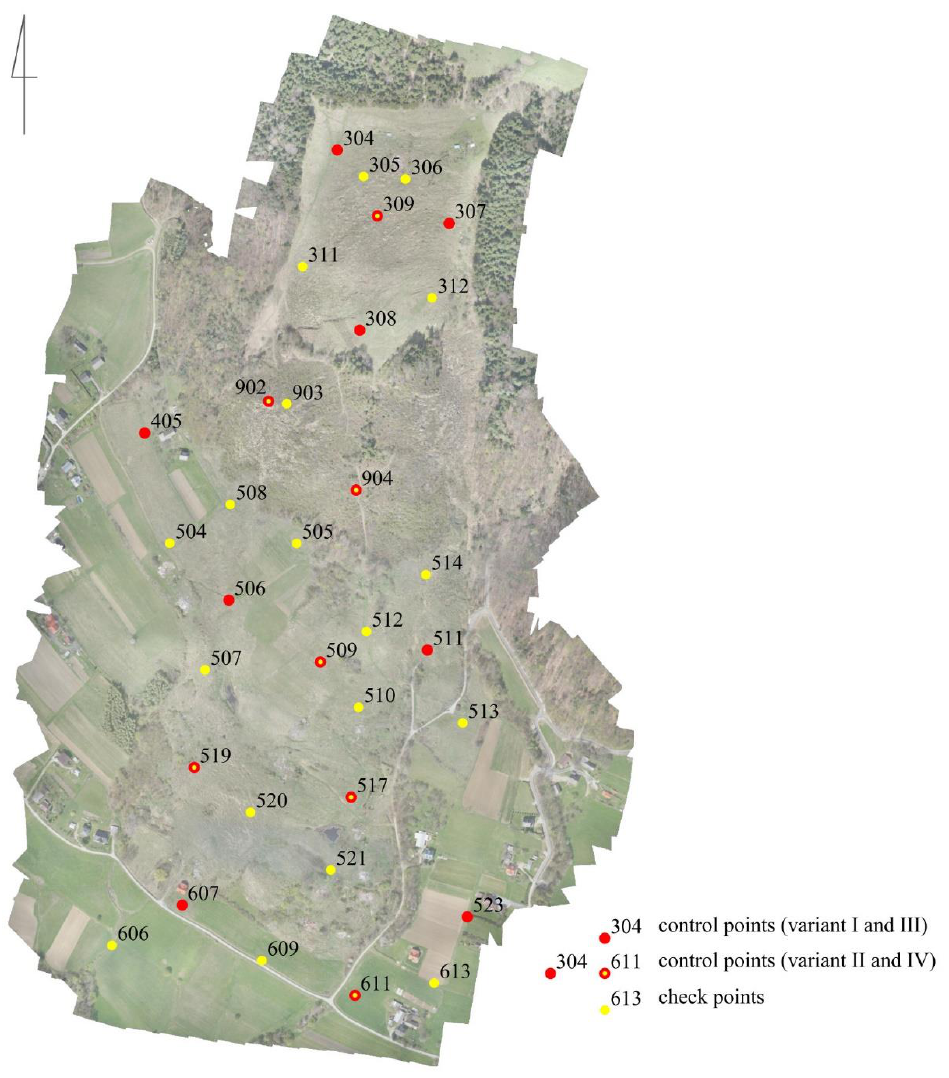
Figure 5. Locations of control points and check points. Table 5. Survey data processing variants.